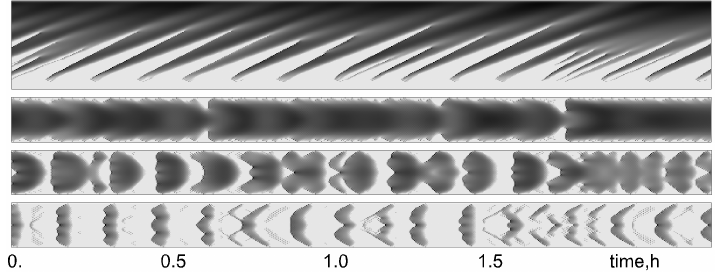
Fig. 5. Keograms of transients in pseudo-periodical regime at B z = − 6nT. Cross sections are the same as for Fig.